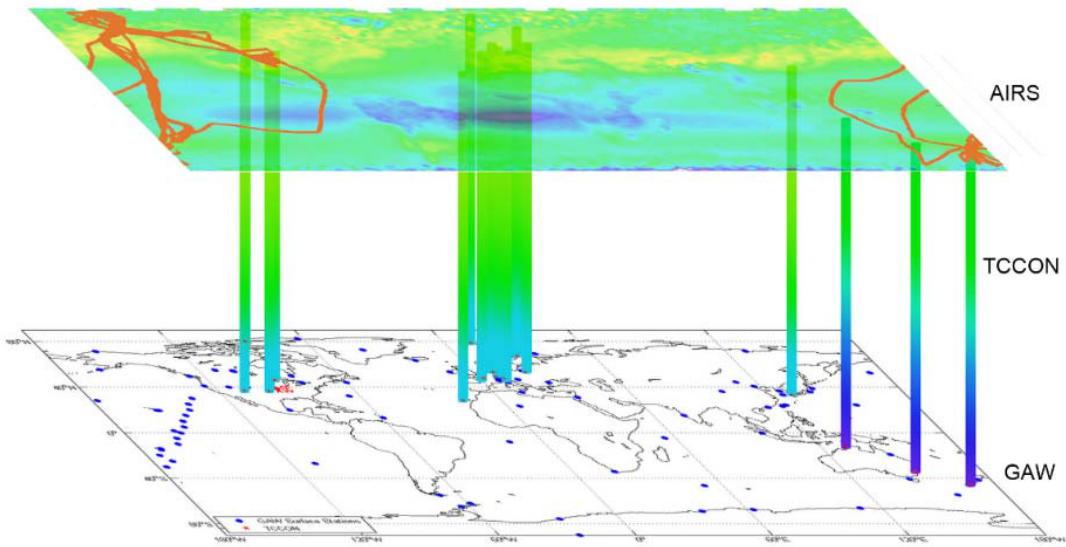
Figure 1. Sketch of spatio ‐ temporal validation: Global Atmosphere Watch Program (GAW) surface stations (blue dots on the floor), Total Carbon Column Observing Network (TCCON) retrievals (colorful columns), HIAPER Pole ‐ to ‐ Pole Observation (HIPPO) flight paths (orange lines) and AIRS observations (colorful ceiling).